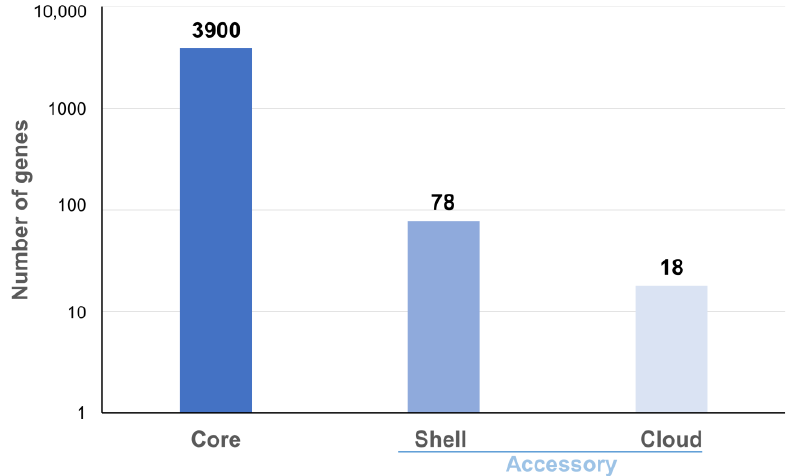
Figure 1. Pan-genomic histogram of 12 complete genomes of M. bovis . The figure shows the core and accessory genes proportion in the genome’s panel.